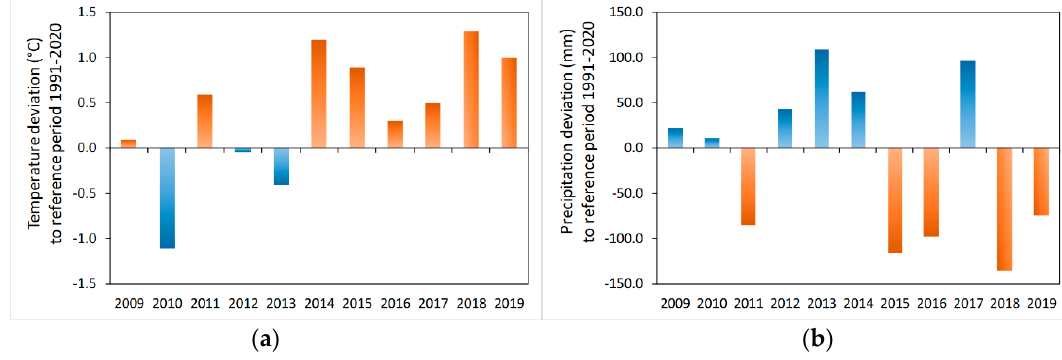
Figure 2. Temperature ( a ) and precipitation trend ( b ) in the Antrift catchment (2009–2019). (Data source: HLNUG (2019); operator: Deutscher Wetterdienst, data for the climate station Alsfeld-Eifa, station-ID: DWD91, 50.7447° N, 9.345° E.).